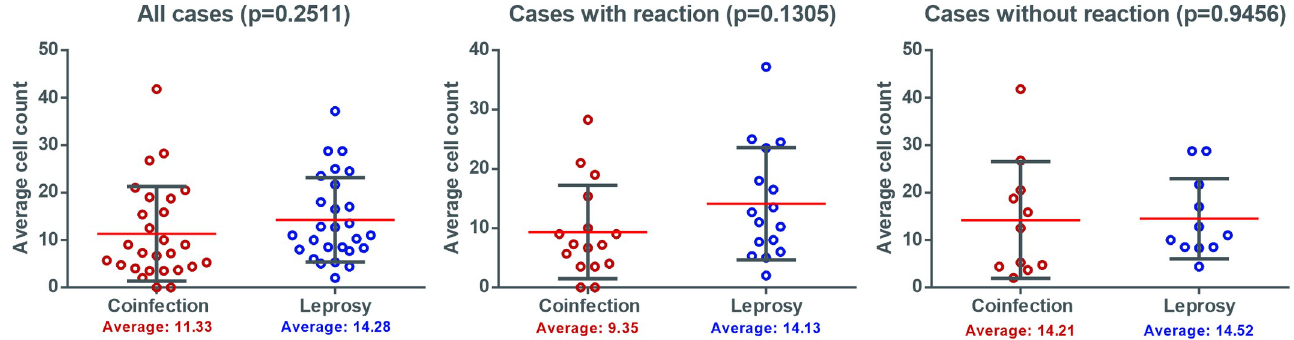
Fig 1. Density of cells expressing FOXP3 in lesions of patients with leprosy with and without HIV co-infection.